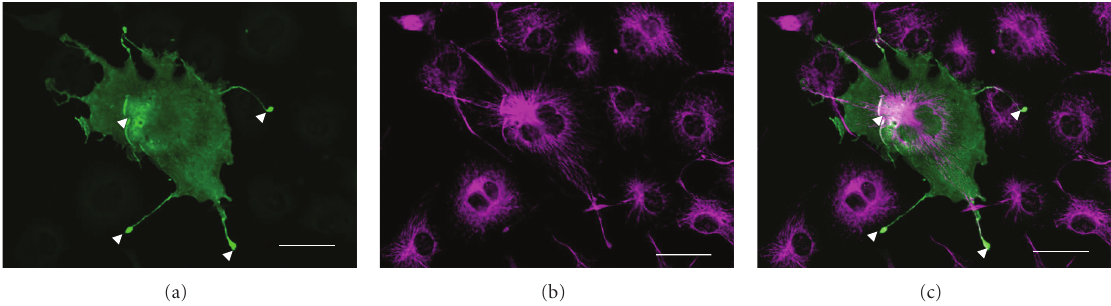
Figure 3: Subcellular localization of newt HN1 protein in COS7 cells. (a) shows the immunoreactivity for the HN1 protein. (b) shows the immunoreactivity for tubulin. (c) shows the composite image of (a) and (b). Arrowheads indicate the relatively high immunoreactive signal of HN1. All scale bars indicate 50 μ